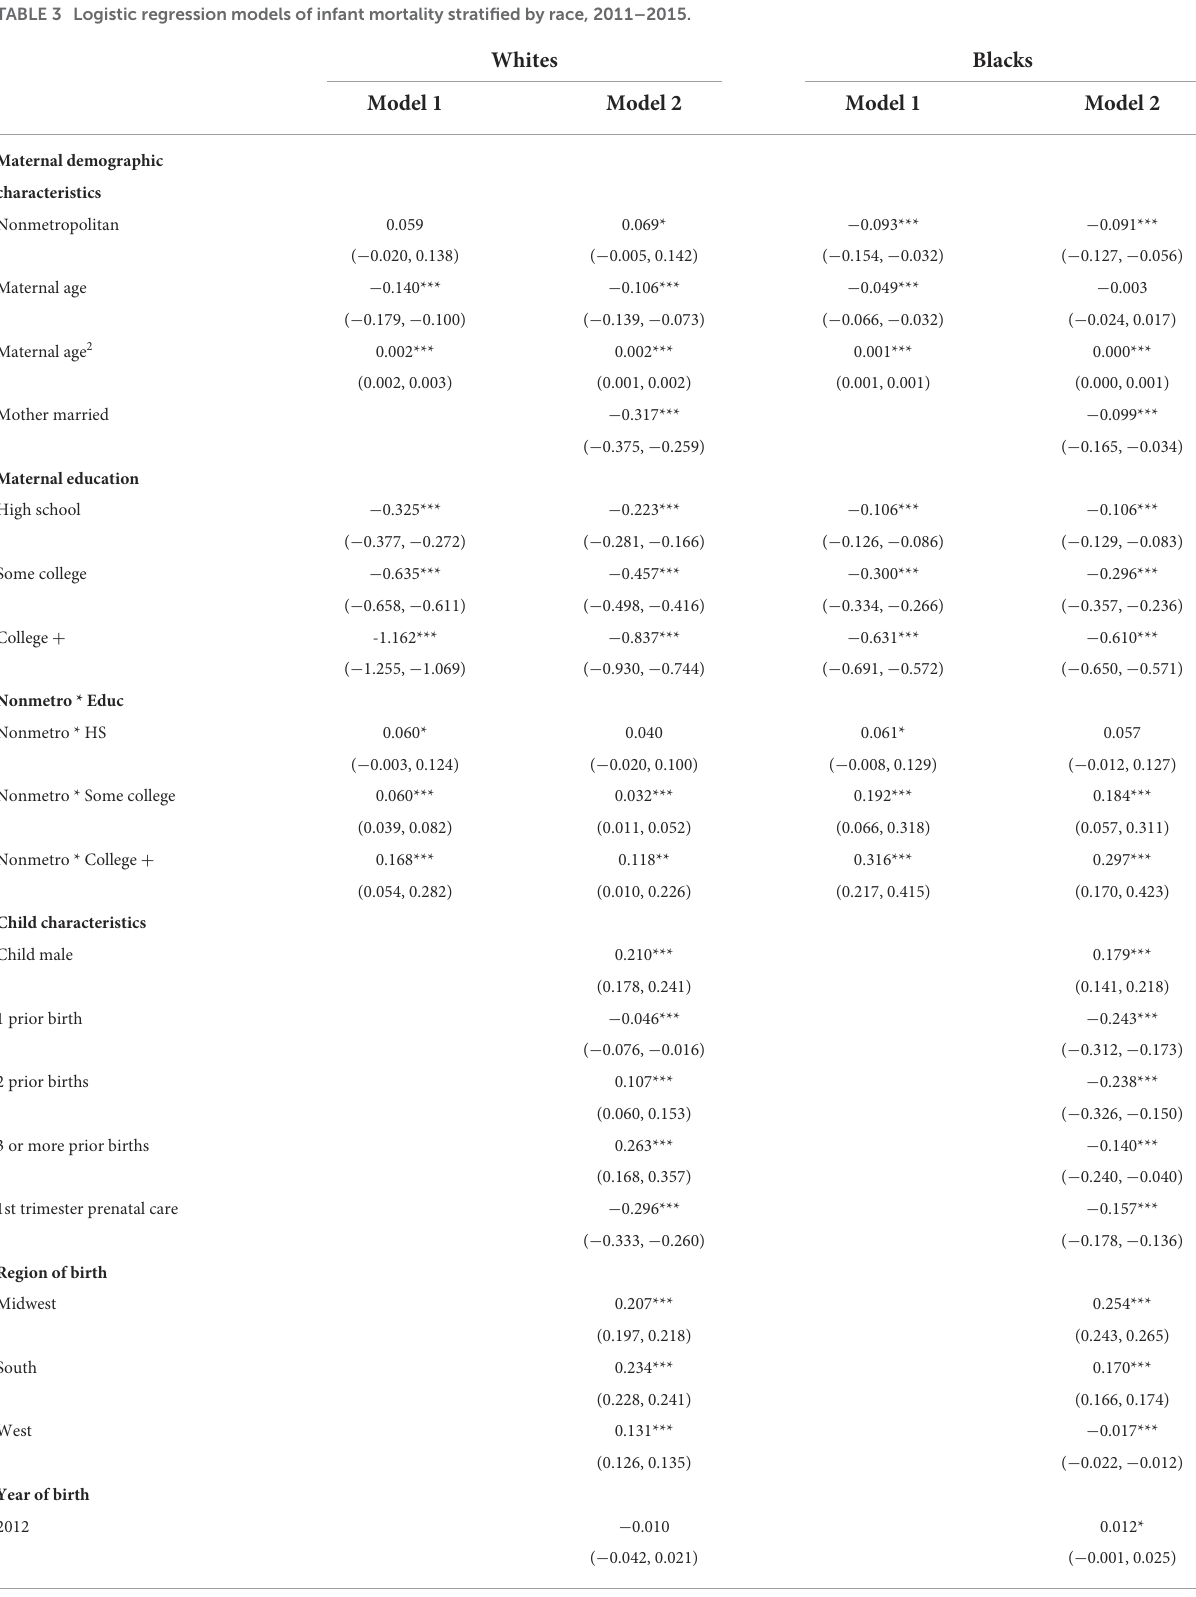
TABLE 3 Logistic regression models of infant mortality stratified by race, 2011–2015.